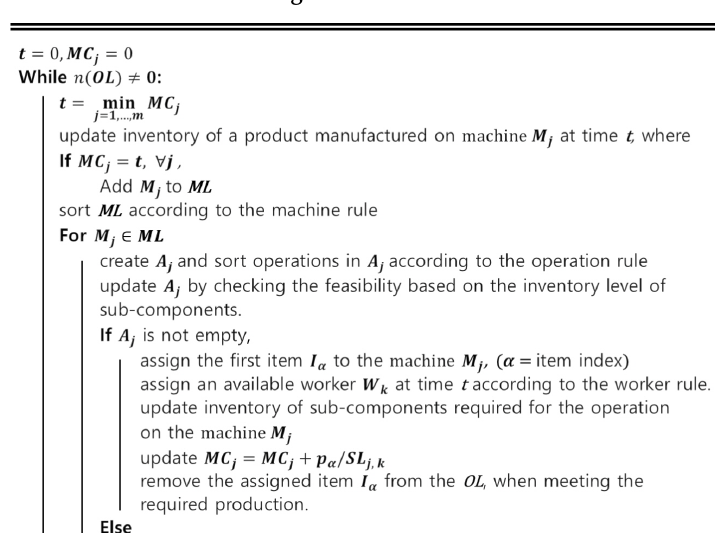
Figure 3. Workload.